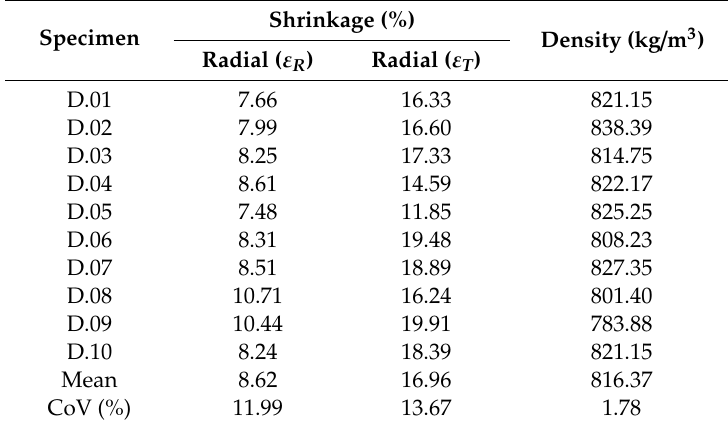
Table 1. Radial ( ε R ) and tangential ( ε T ) linear shrinkage measured on the eucalyptus wood specimens according to ISO 13061-1 [24].